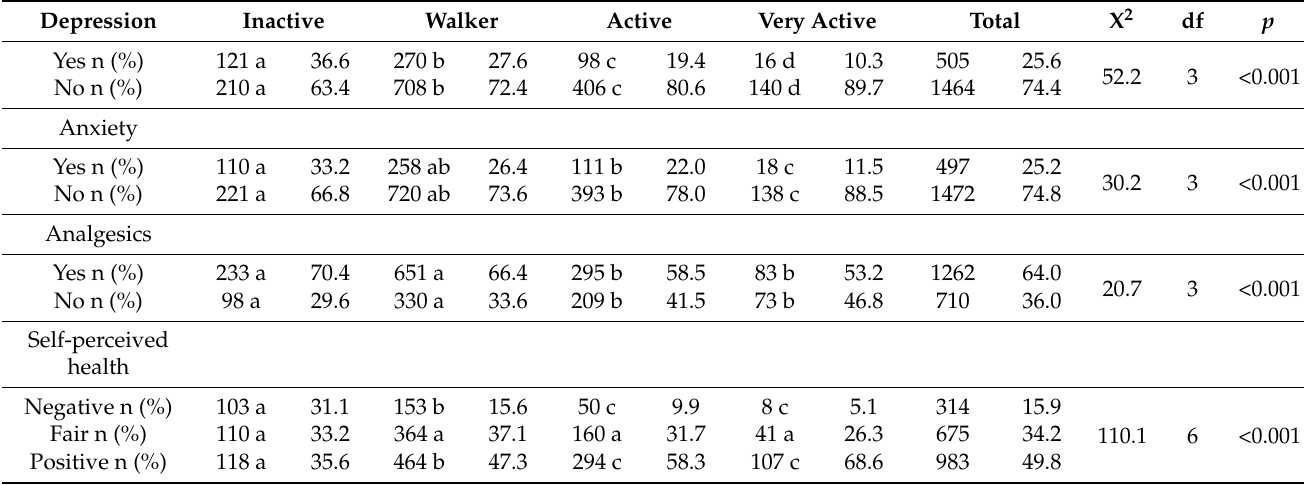
Figure 3. Prevalence of negative and positive self-perceived health, according to physical activity level. Table 4. Self-perceived health, analgesic intake, and prevalence of depression and anxiety in people with migraines as a function of physical activity level. Intergroup comparisons and dependency analy- sis between depression, anxiety, analgesic intake, self-perceived health, and level of physical